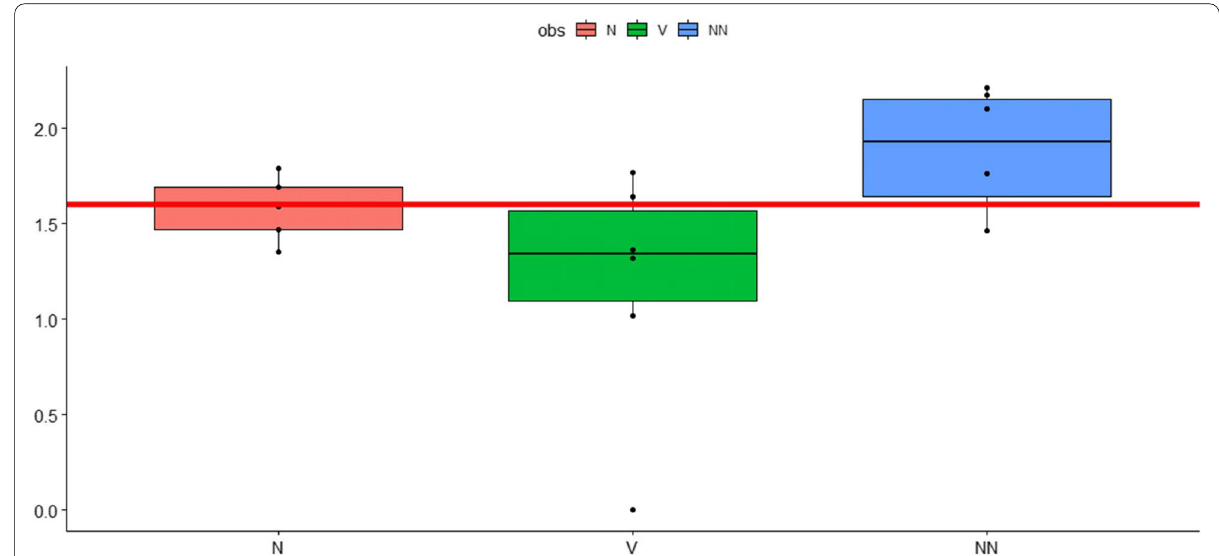
Fig. 1 Bioenergetic Health Index (BHI). The individual parameters from the mitochondrial stress test (MST) can be integrated as a bioenergetic health index (BHI). BHI values were determined before, after the first 10-passes OHT and after the second 10-passes OHT one week later. Cumulative data from six patients expressed as mean s.e.m. P -values: 0,045 (NN versus V); 0,198 (N versus V); 0,079 (N versus NN). COHEN: 1,385,603 (NN versus ± V); 0,8,039,162 (N versus V); 1,152,394 (N versus NN). ANOVA: 0,0,373,088 (NN versus V); 0,325,814 (N versus V); 0,4,969,881 (N versus NN). V: before OHT; N: after the first OHT; NN: after the 2. OHT (one week later). Y-Axis: BHI; X-axis: sampling